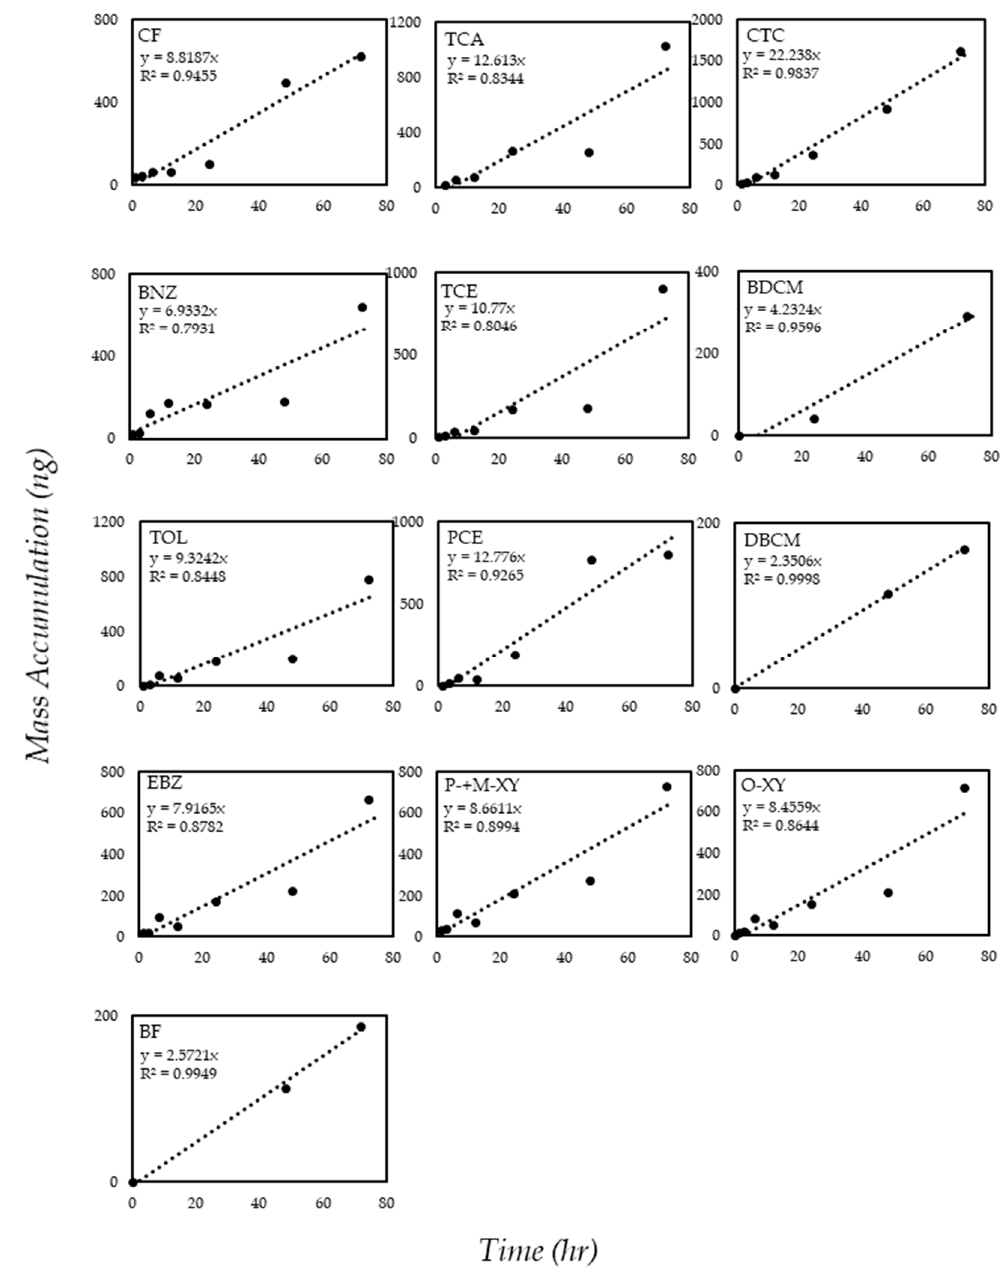
Figure 2. The mass accumulation of volatile organic compounds (VOCs) with time, representing the linear kinetics of the solid ceramic dosimeter at a VOC concentration of 43.11 (±6.72) μ